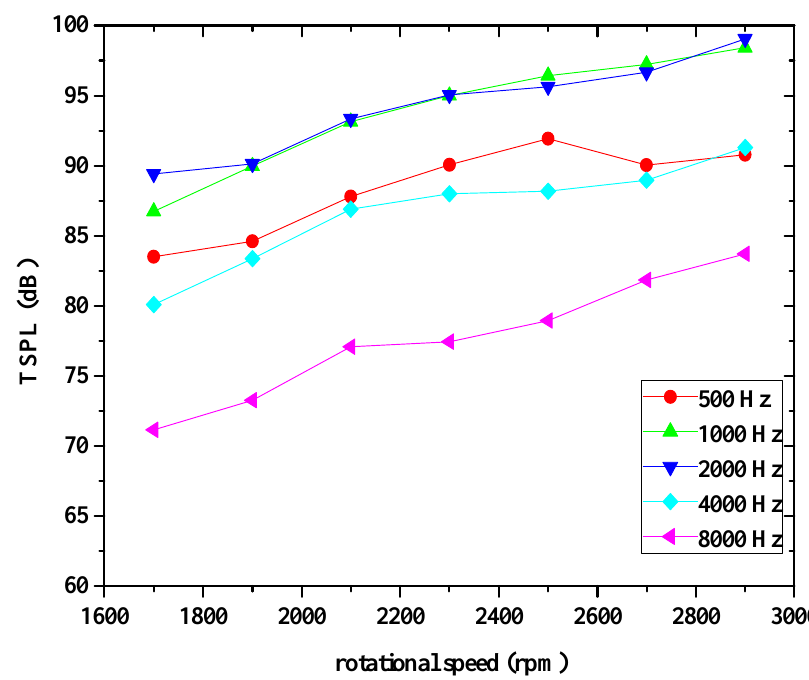
Figure 6. Changes in total sound pressure level (TSPL) at certain frequencies under various rotational speeds.